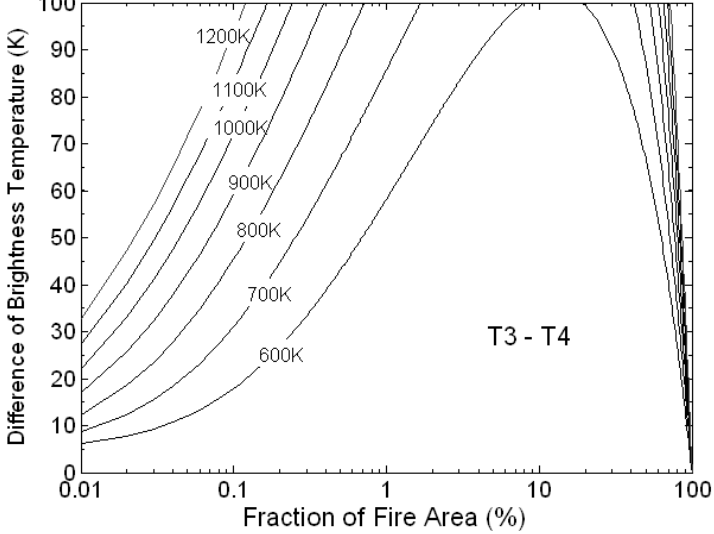
Figure 2. The difference of brightness temperature between MIR and TIR channel of HJ-1B